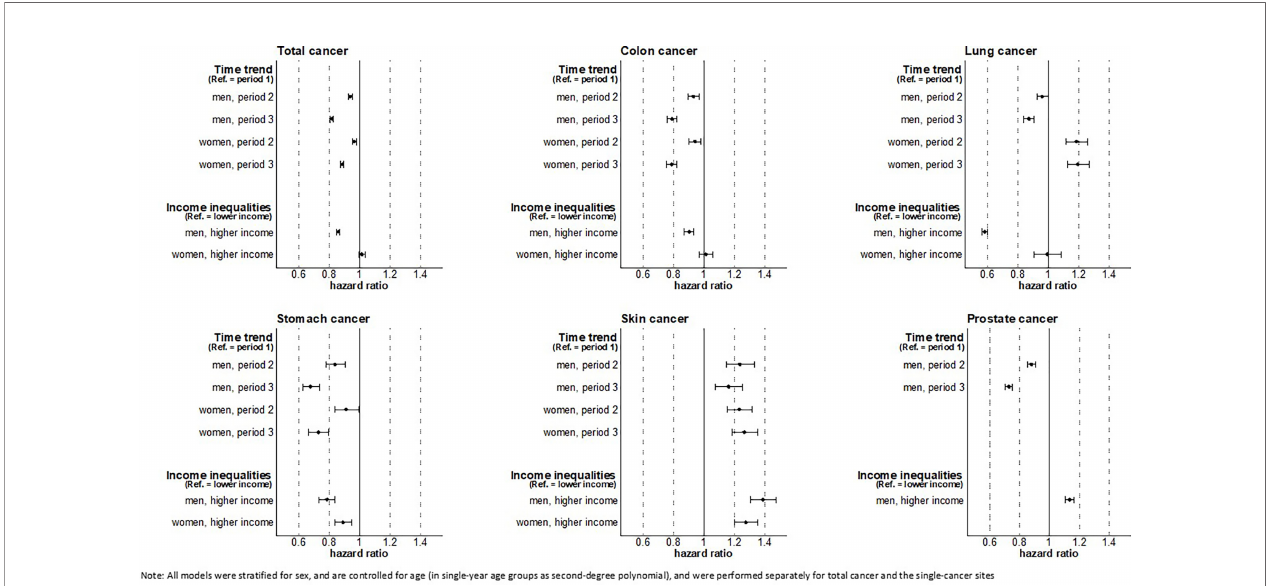
FIGURE 2 | Time trend and overall income inequality in cancer risk in men and